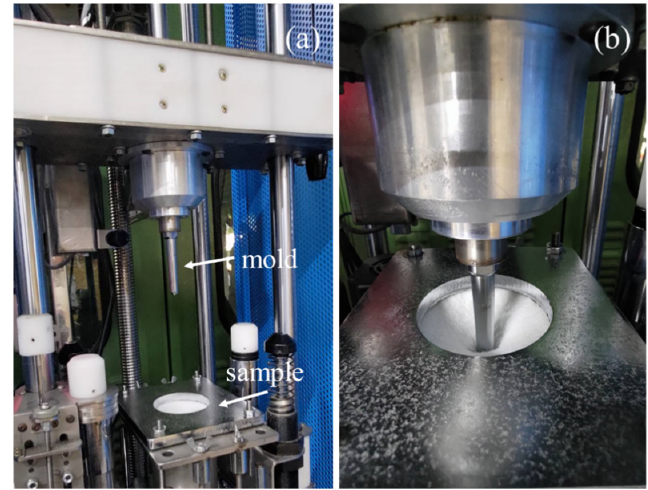
Figure 4. ( a ) Schem of dynamic impact strength test; ( b ) Test the situation.